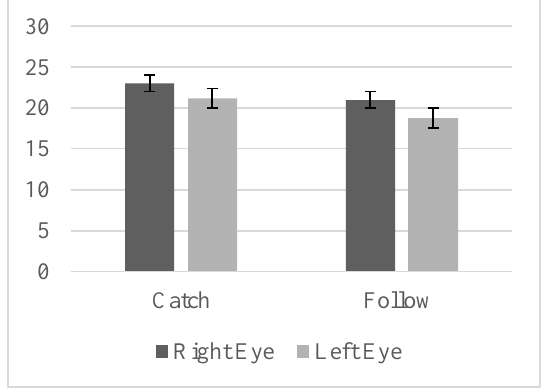
Figure 7. Left- and Right-Eye Pupil Size Differences under Both Hands Condition for Novices